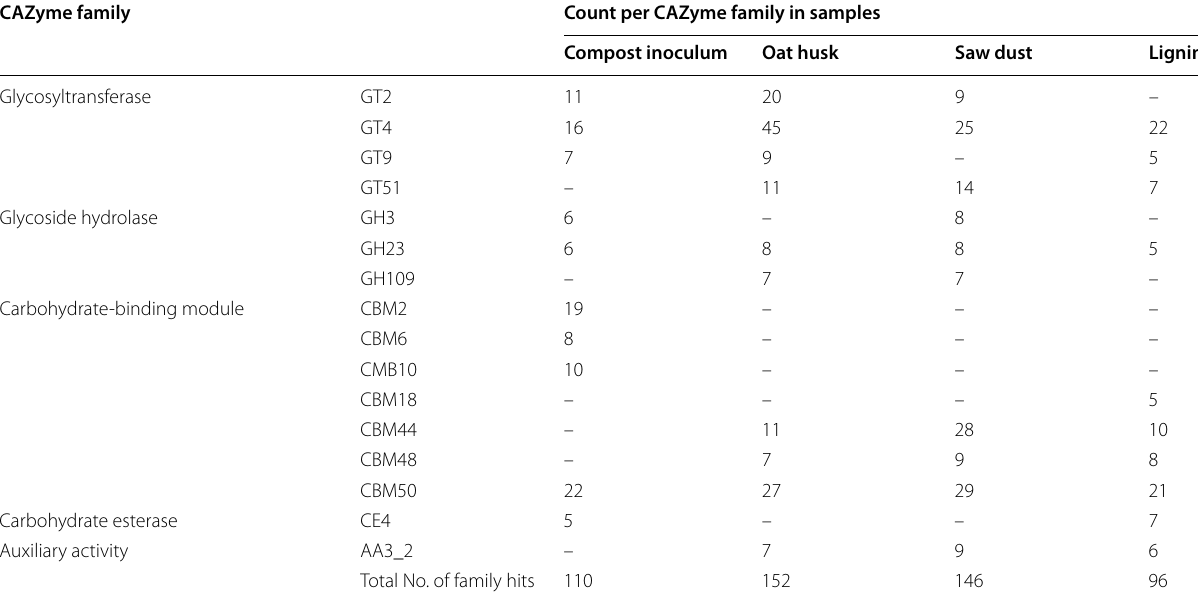
Table 1 Detailed breakdown of the 10 most abundant CAZyme hits belonging to the different enriched samples and compared to the original compost inoculum. Results presented as number of CAZyme family hits per sample CAZyme